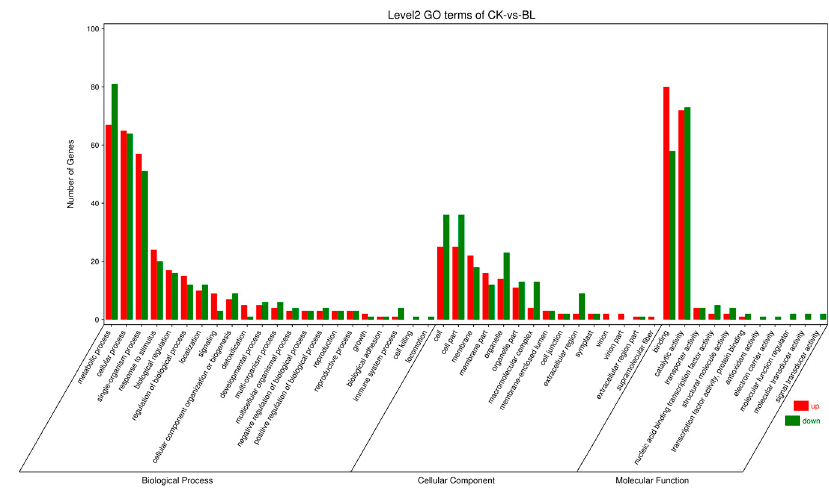
Figure 7. Histogram of GO enrichment and classification of differential genes. The abscissa is the secondary GO terms, and the ordinate is the number of differential genes in the term. Red indicates upregulation and green indicates downregulation.